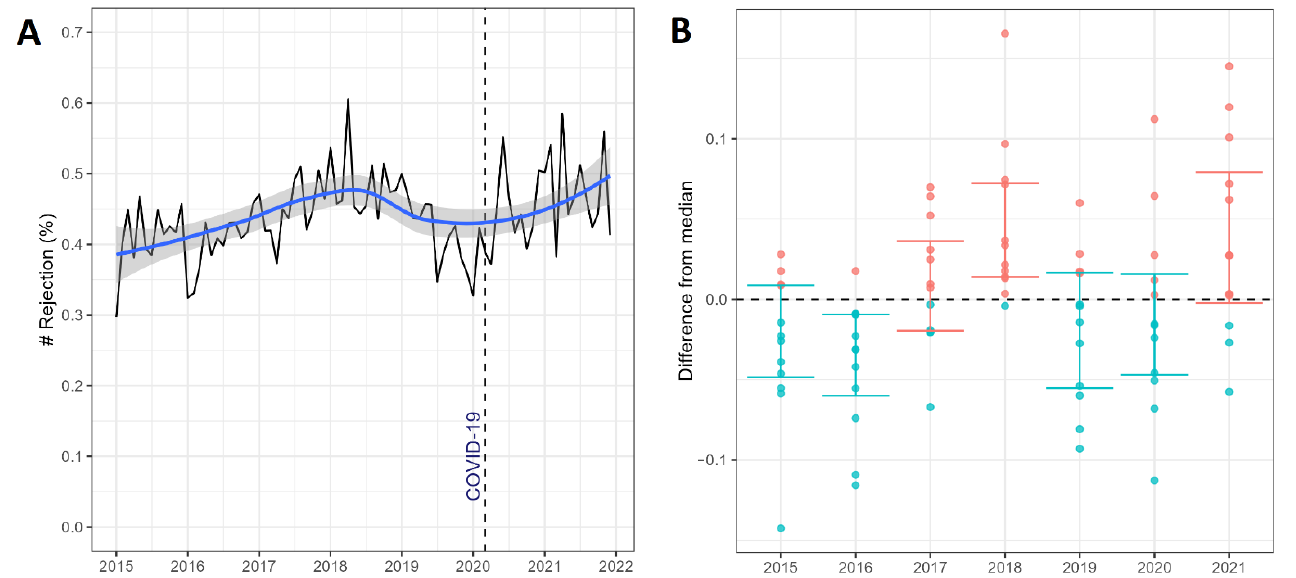
Figure 3. Total rejection episodes corrected for the number of transplants performed in Brazil’s Unified Healthcare System (SUS). ( A ) Monthly data plot divided into pre-pandemic (January 2015 to March 2020) and COVID-19 pandemic (March 2020 to December 2021) periods. ( B ) Normalized plot (difference from the median) per year from January 2015 to December 2021. #: number.